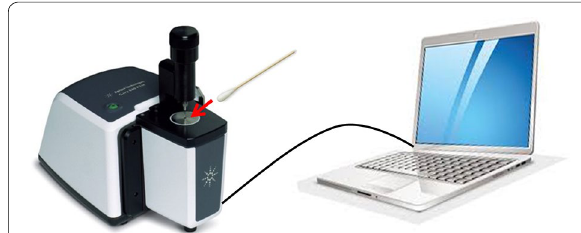
Fig. 2 Measuring adherence by spectroscopy using the Agilent Cary 630 FTIR Spectrometer. A vaginal swab is placed directly on the “diamond” (red arrow) whereby a laser is projected onto the swab to generate a spectral scan. The spectral scan is analyzed through discriminant model algorithms on the laptop for a final “yes” or “no” output